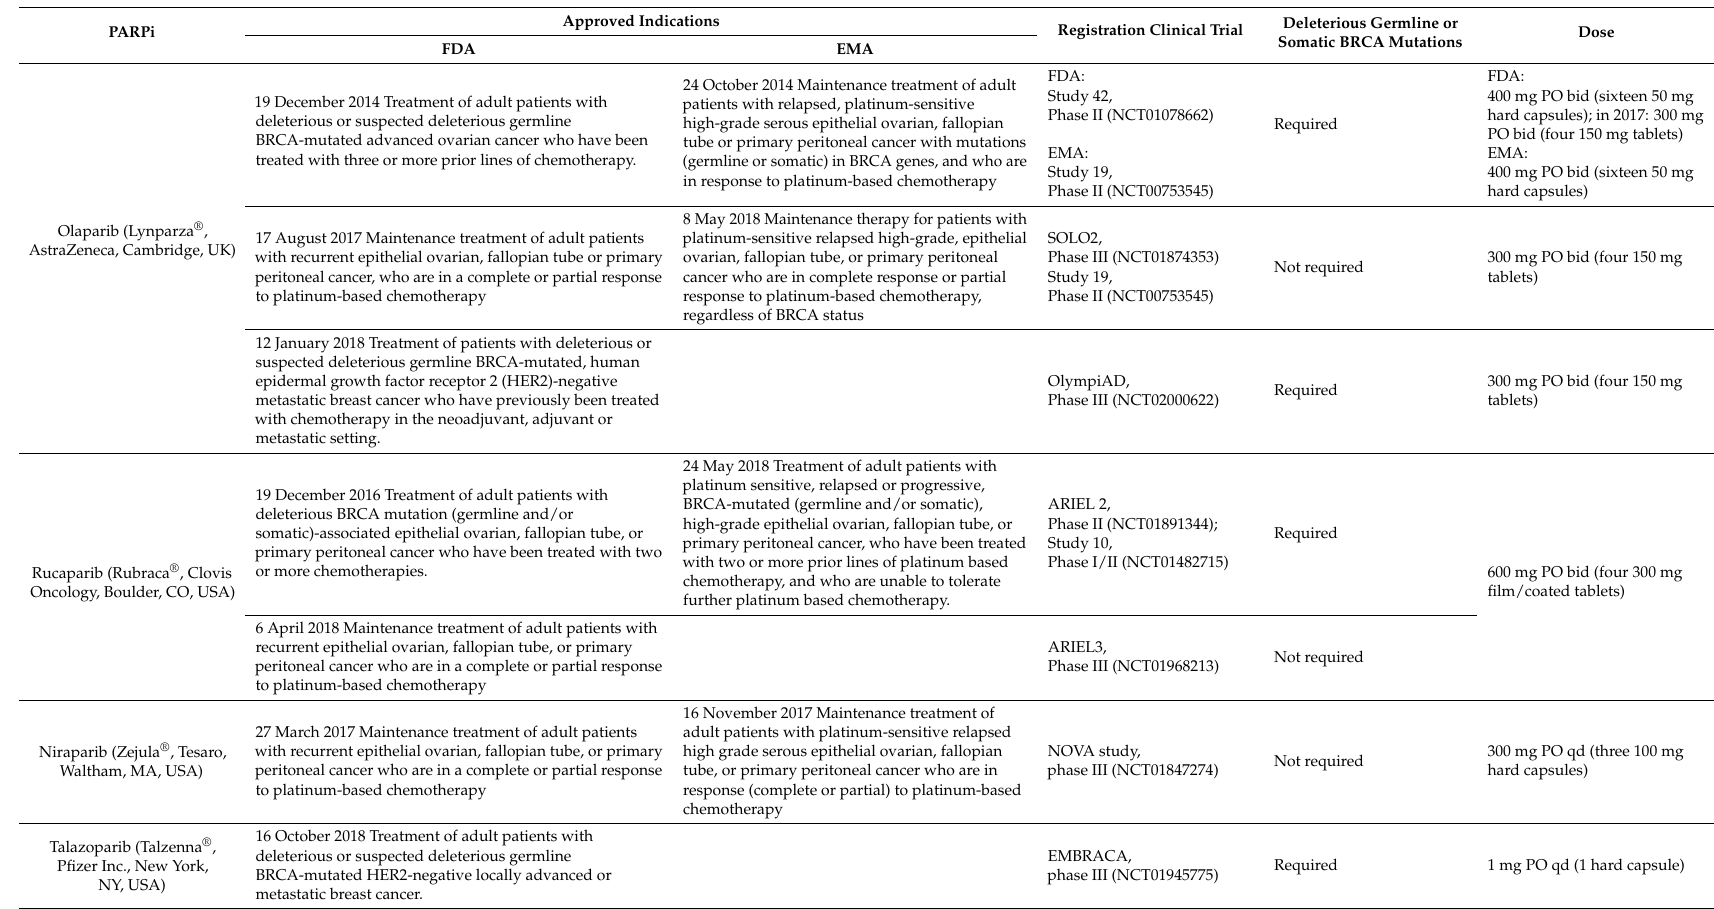
Table 1. FDA and EMA approval of PARP